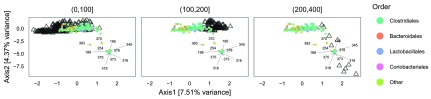
The mouse and bacteria scores generated by CCpnA.The sites and species are triangles and circles, respectively. The separate panels indicate different age groups.